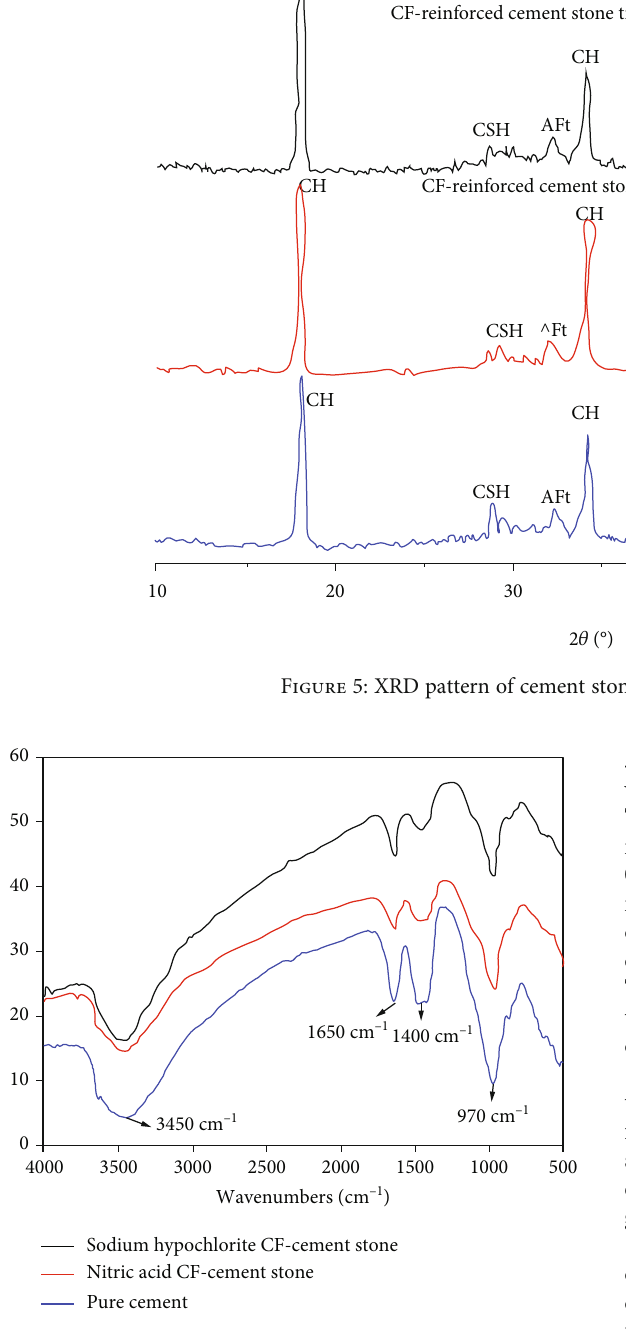
Figure 6: FTIR of cement stone with 0.2% CF for 7